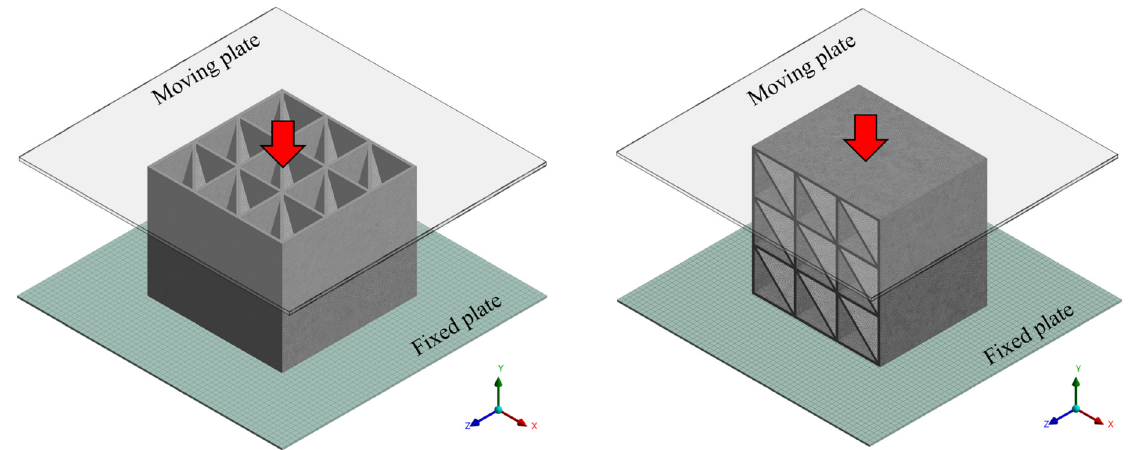
Figure 5. FE model of novel honeycomb under axial ( left ) and lateral ( right ) loading conditions. Table 2. FE analysis settings.